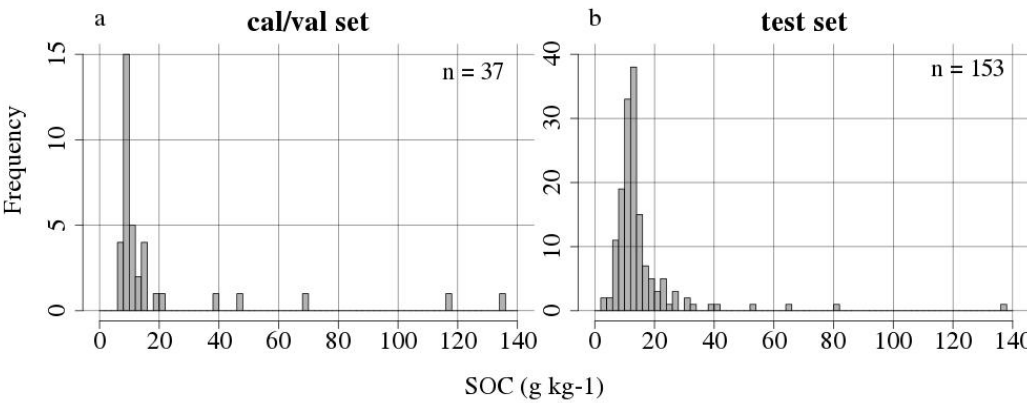
Figure 2. Frequency of the measured soil organic carbon (SOC) content (g kg − 1 ) for the top soil sampling in the Demmin study site area used for model calibration and validation ( a ) and for model testing ( b ). Table 1. Statistical summary of the three datasets.